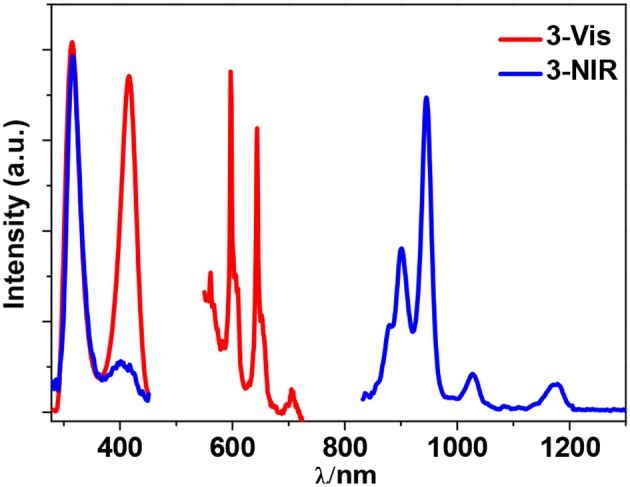
Excitation and emission spectra for 3 in CH3CN.